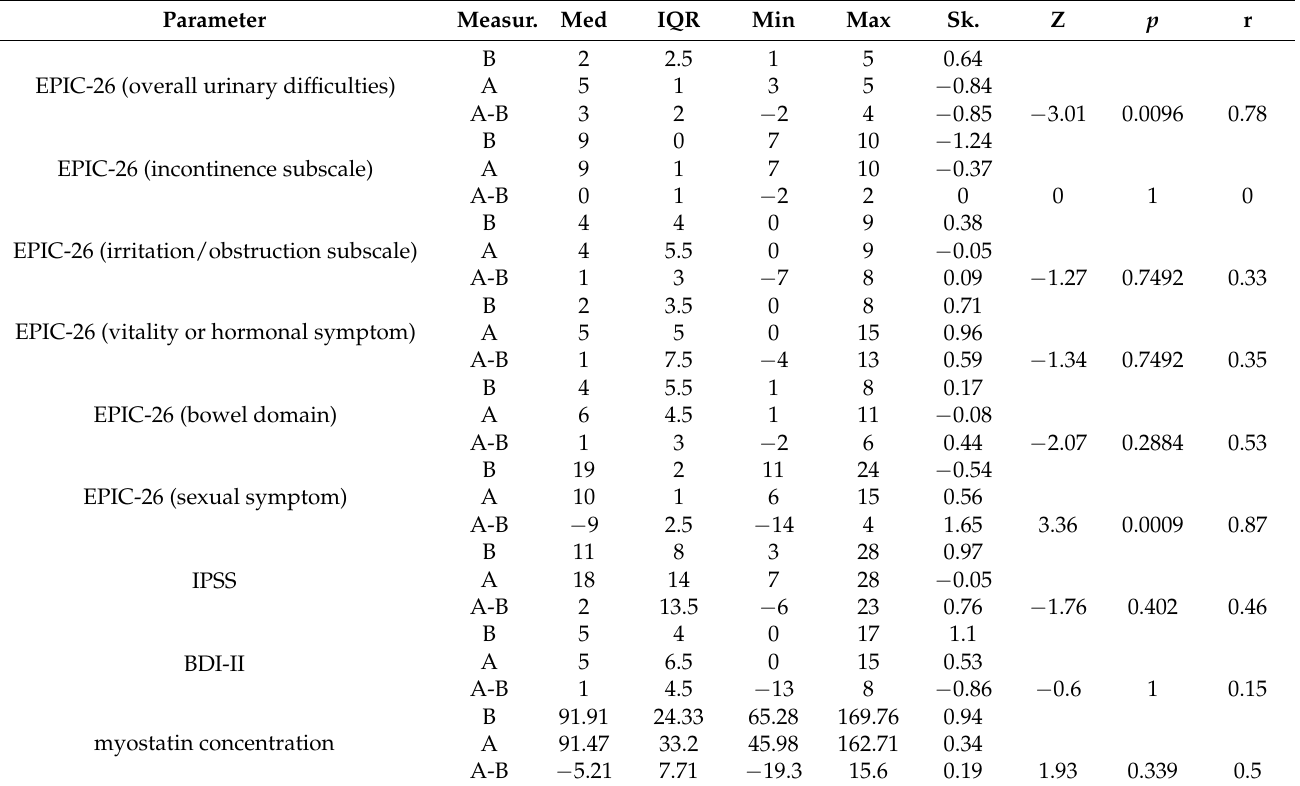
Table 4. Comparative analysis of variables measured for the CG at the initial and final assessments.